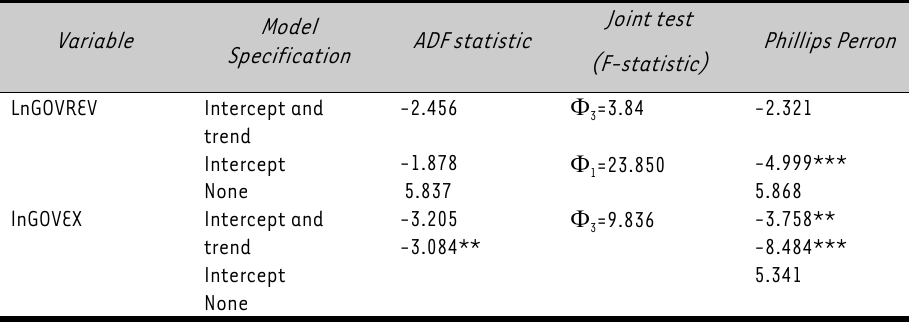
TABLE 1: ADF and Phillips-Perron unit root tests Variable